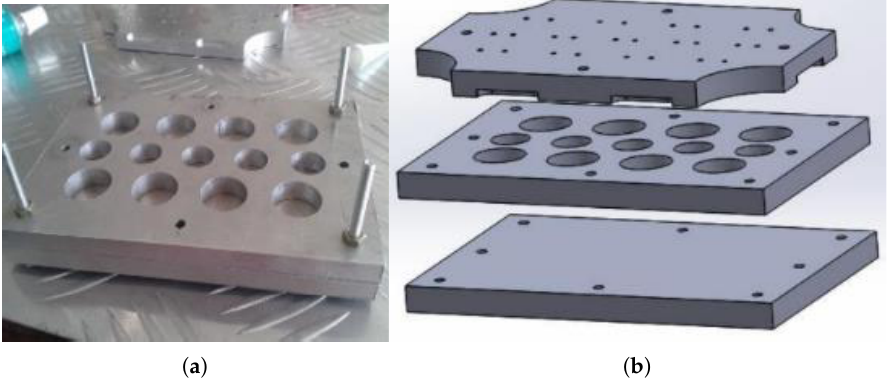
Figure 11. Mould used to fabricate sensor pills: ( a ) aluminium—press mould; ( b ) exploded view of the mould.